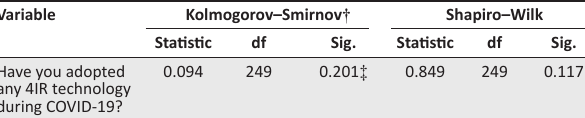
TABLE 3: Normality tests.